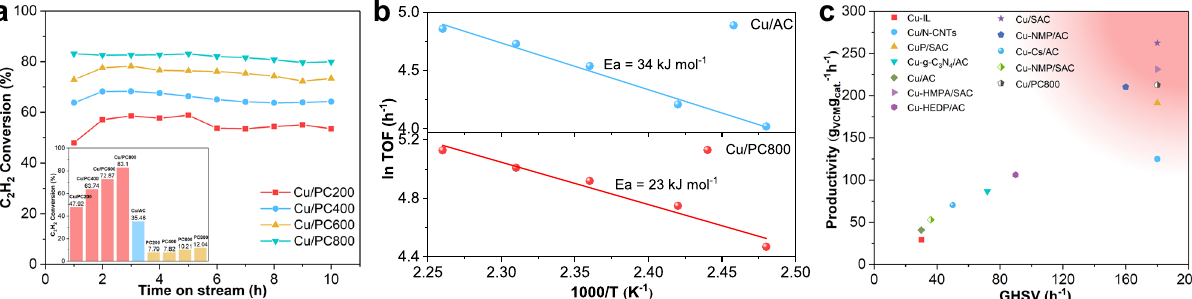
Fig. 2 Catalysts performance level and kinetic results. a The conversion of acetylene over P-doped Cu-based catalysts. Reaction conditions: temperature = 150 °C, GHSV(C 2 H 2 ) = 90 h − 1 , V(HCl)/V(C 2 H 2 ) = 1.2/1; Comparison of acetylene conversions for Cu/PC200, Cu/PC400, Cu/PC600, and Cu/PC800 catalysts and their respective treated carbons, b Kinetic studies of Cu/AC and Cu/PC800 catalyst: apparent activation energy, kJ mol − 1 , c GHSV plotted against the Productivity for some copper-based catalysts reported in literature and Cu/PC800 catalyst with better catalytic performance in this article.